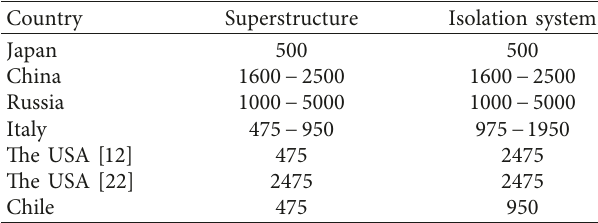
Table 3: Return period ( T R ) of the design input (years).